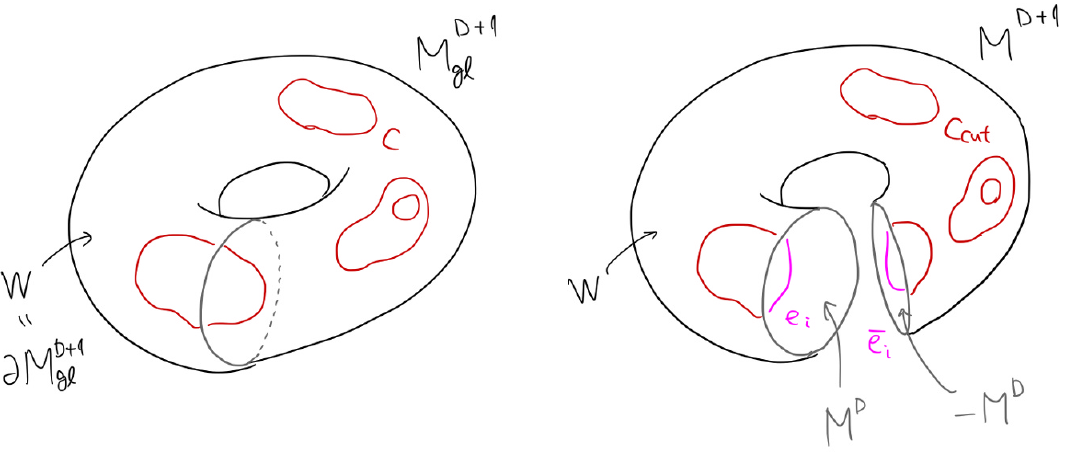
Figure 5 . Illustration of the gluing